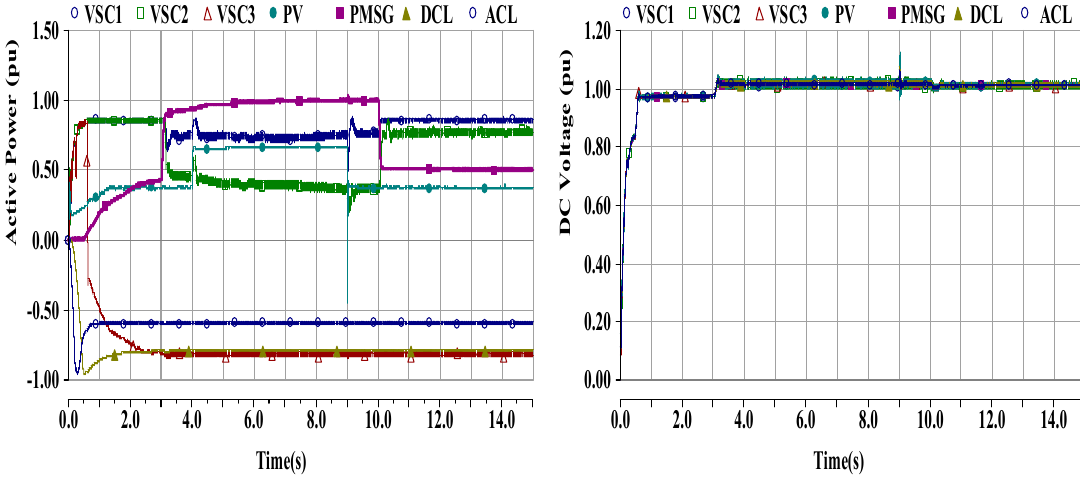
Figure 8. Active power and DC voltage under the proposed hierarchical control with DC OPF secondary control during variations of renewable energies (REs).